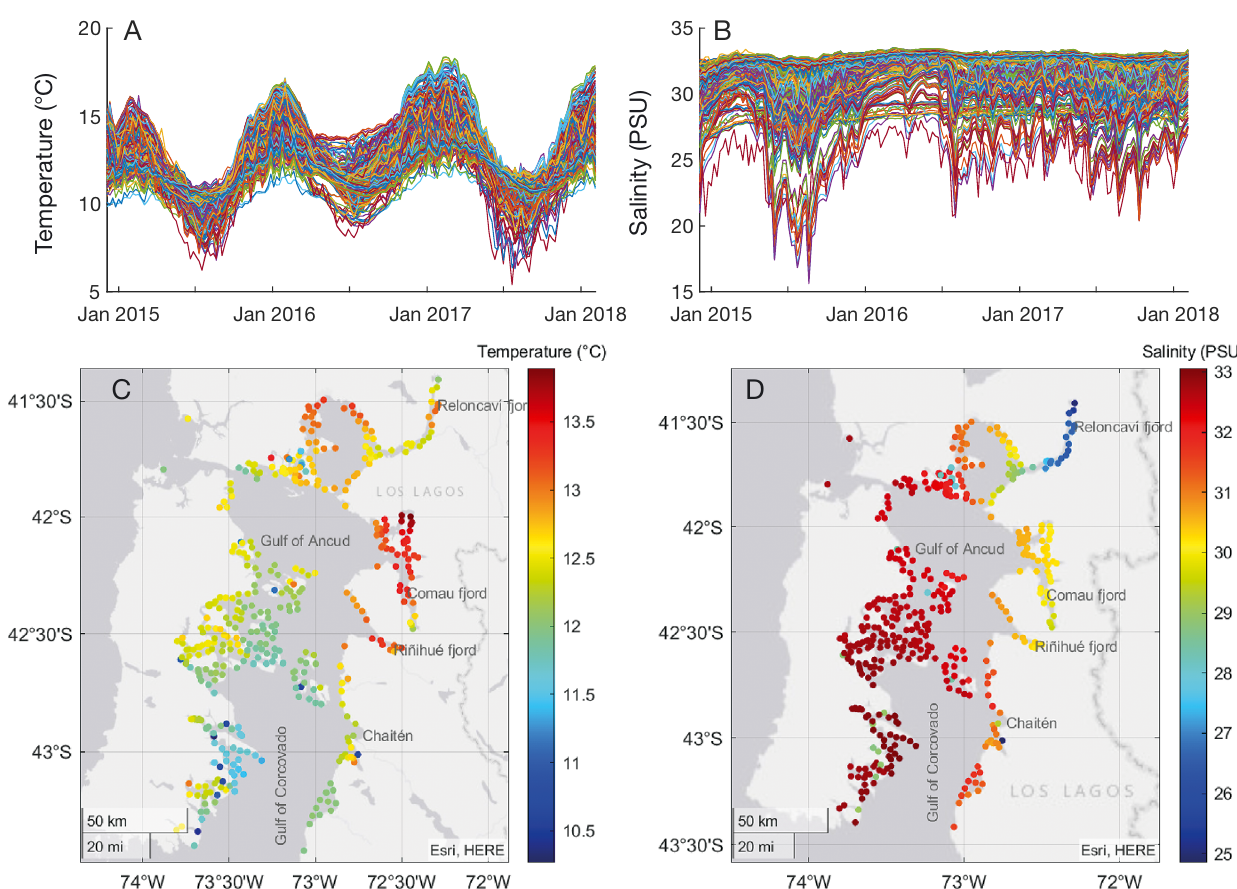
Fig. 4. Time series of depth-integrated (A) temperature and (B) salinity records for the upper 20 m at 498 fish farm sites located in the Los Lagos region, and model predictions of the mean (C) temperature and (D) salinity at 478 fish farm locations in the Los Lagos region for the period